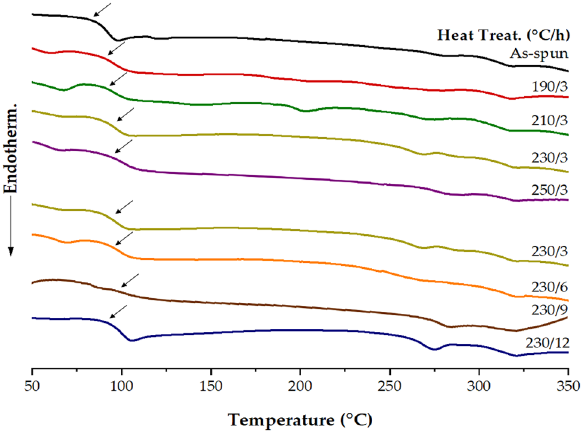
Figure 2. DSC thermograms of TLCPs with various heat treatment conditions.